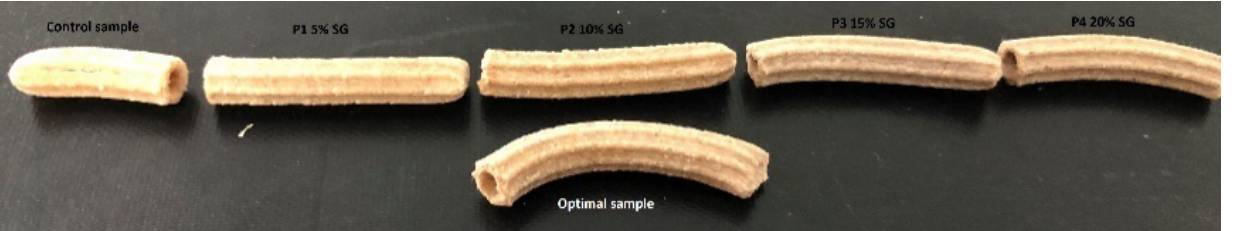
Figure 2. Spent grain pasta [84].